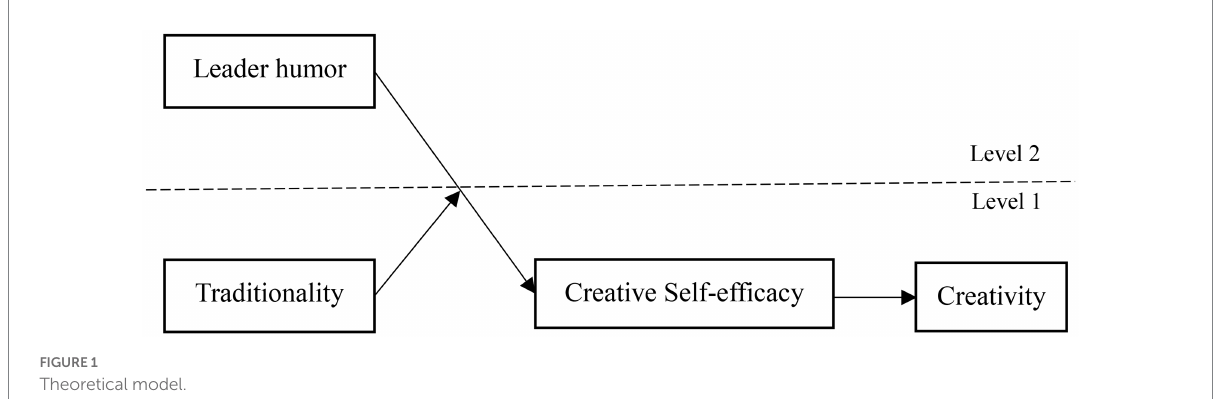
FIGURE 1 Theoretical